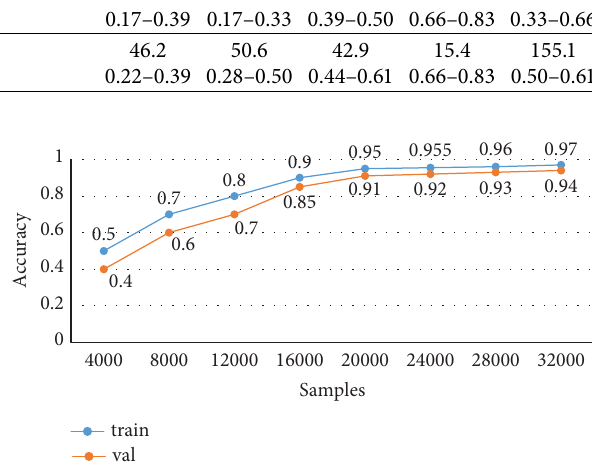
Figure 2: Classifcation accuracy of ranking SVM with diferent sample